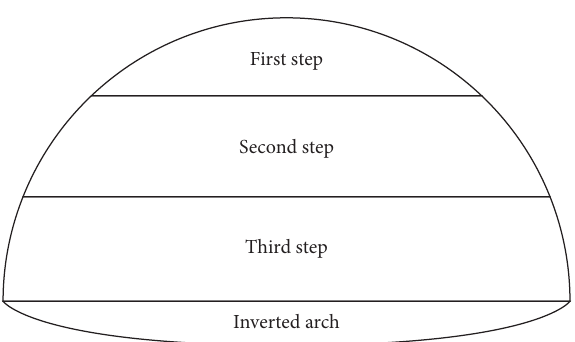
Figure 9: Construction sketch of the three-step